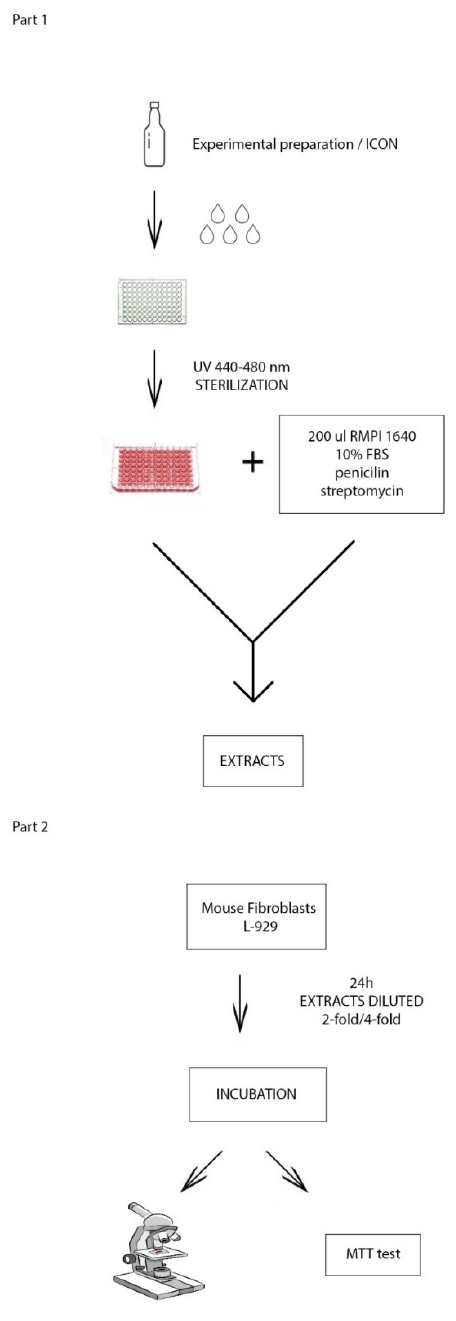
Figure 4. (Part 1) Scheme for obtaining 24 h extracts. (Part 2) Scheme for assessing cell